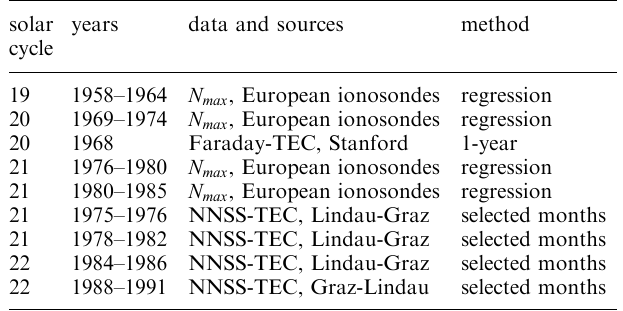
Table 3. Data sources for the figures with F-layer ionization